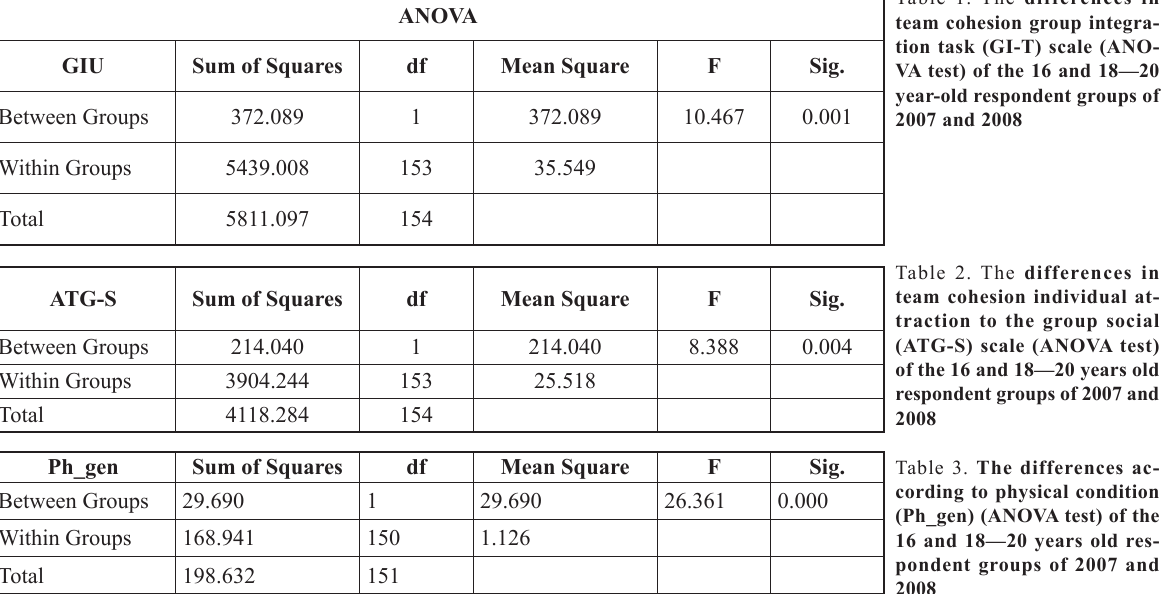
Table 1. The differences in team cohesion group integra-